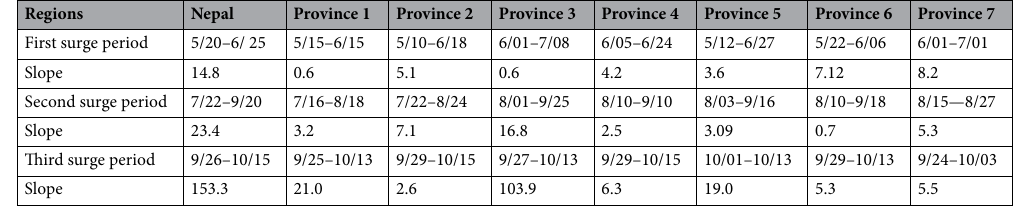
Table 1. The slope of the linear model and the duration of the linear trend for three surge